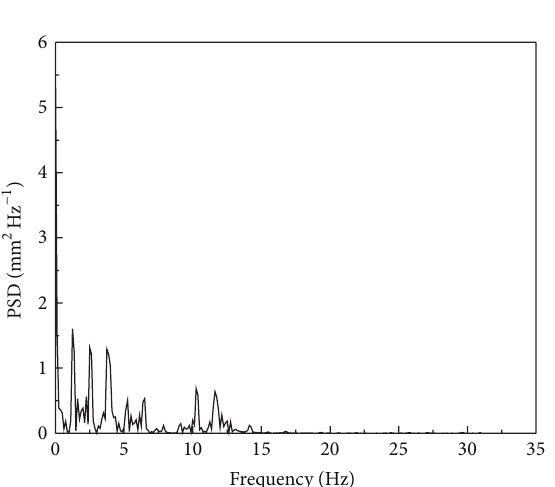
Figure 10: PSD of the displacement at the shell-soil contacting position in the frequency domain.